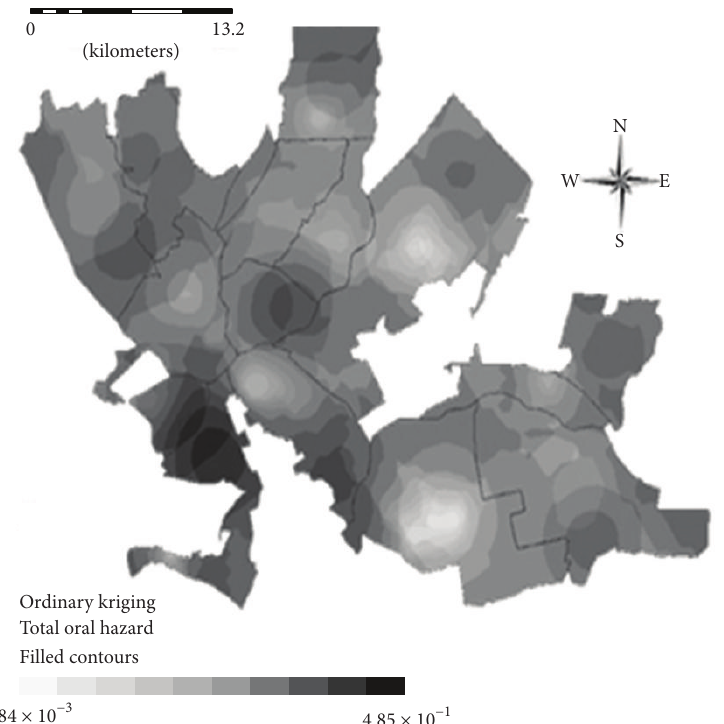
F 6: TTHM hazard index via oral route.